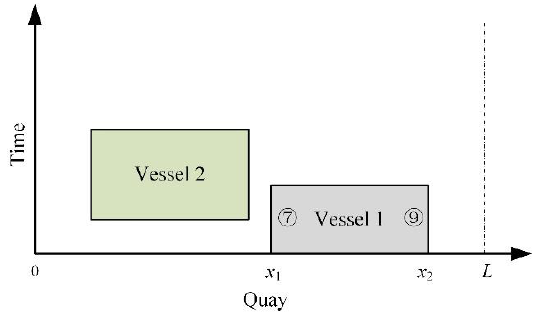
Figure 4. Impact of vessels already served at the beginning of the planning period. (Source: compiled by the authors).